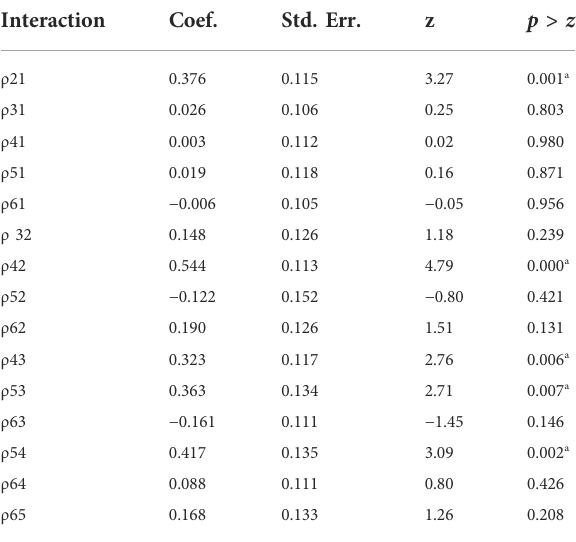
TABLE 6 Estimated covariance matrix of the regression equations between agroecological practices using MVP model. Interaction Coef. Std. Err.